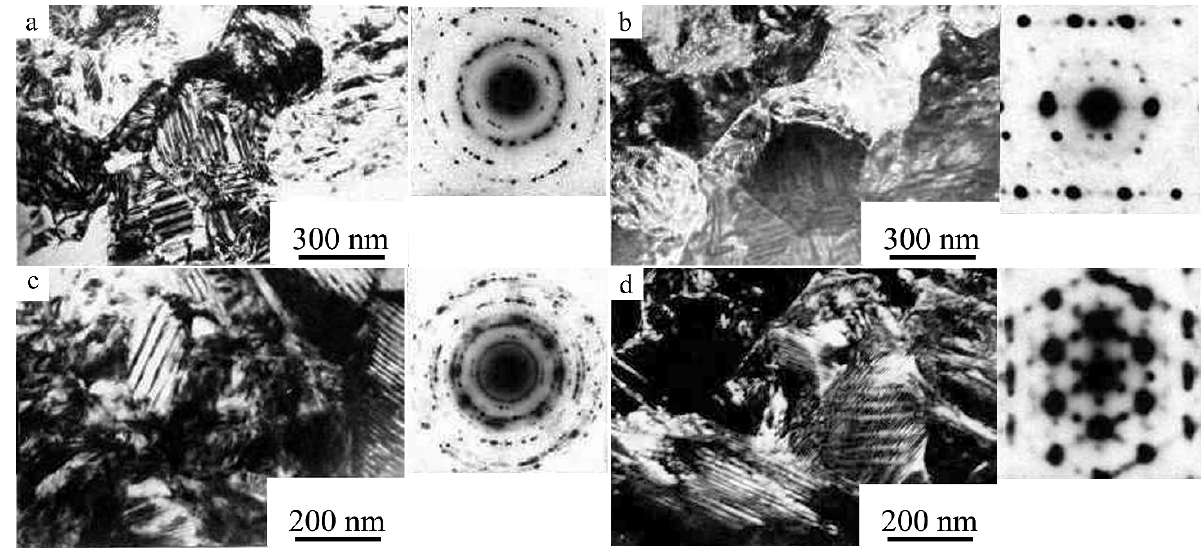
Figure 6. ( a , c ) Bright- and ( b , d ) dark-field TEM images of the ( a , b ) R - and ( c , d ) B 19’ modes of martensite microstructure of the UFG Ti 49.4 Ni 50.6 alloy obtained by ECAP at 723 K, 8 passes and ( a – d ) the corresponding SAED patterns obtained by ( a , c ) SD 1 µm and ( b , d ) SD 0.3 µm [54]. The deformation-assisted behavior of Ti 49.4 Ni 50.6 alloy in CG and UFG states was studied during tensile tests of standard cylindrical samples with a diameter of 3 mm. The value of the true stress, denoted by the symbol «S», was calculated under the assumption that the samples undergo uniform deformation during tensile tests: S = P ε / F ε , where P ε is the force exerted by the tensile-testing machine at the degree of deformation ε , F ε = F 0 /(1 + ε ) is the cross section, F 0 is the initial cross section, ε = ( l − l 0 )/ l 0 is the relative deformation (strain), and l 0 and l are the initial and the current length of the sample, respectively. Figure 7a shows “true stress S–strain ε ” curves typical of tensile tests when samples of Ti 49.4 Ni 50.6 alloy are stretched in the pre-martensitic state (at RT): curve 1 corresponds to the initial CG alloy after its quenching, curve 2 corresponds to the initial UFG alloy after ECAP at 723 K in 8 passes. Table 2 contains the measured strength and ductility characteristics.